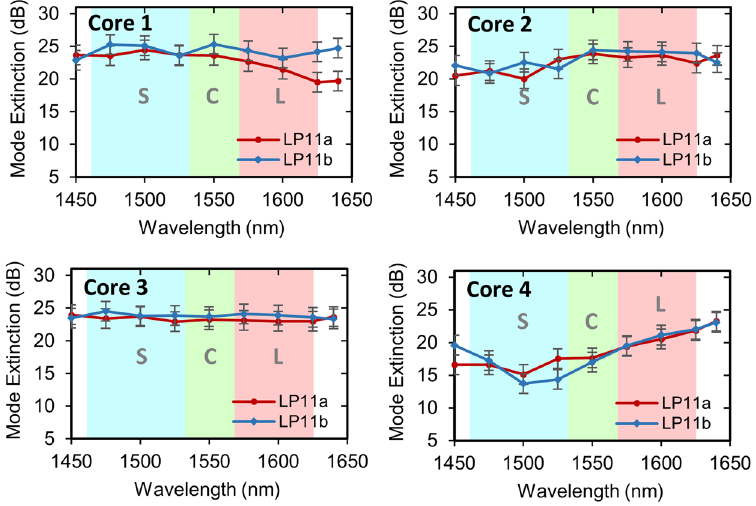
Figure 2. Chip mode extinction ratios. Shown are the mode extinction ratios (power ratio between LP 01 and LP 11 modes) for each of the four tapered mode couplers in the FM-MCF spatial multiplexer